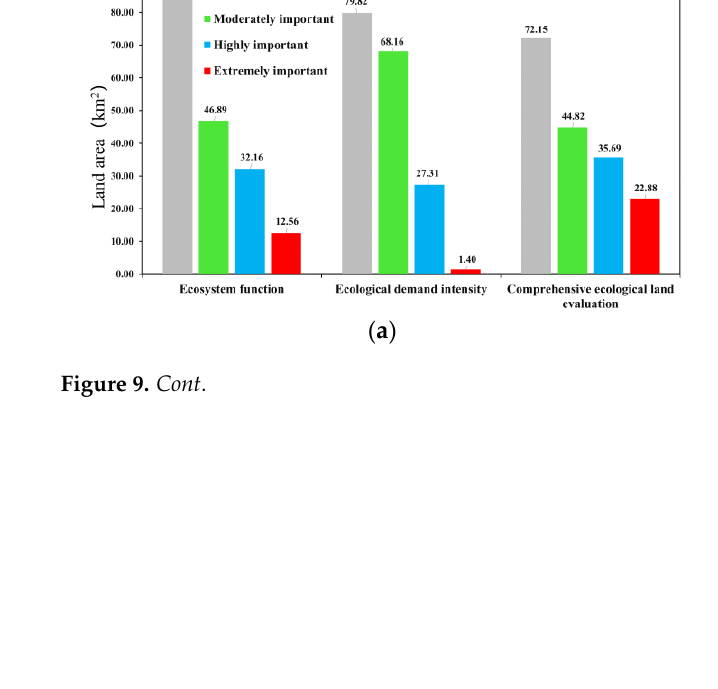
Table 3. The integrative weights of factors for evaluating the ecological values of urban green space.